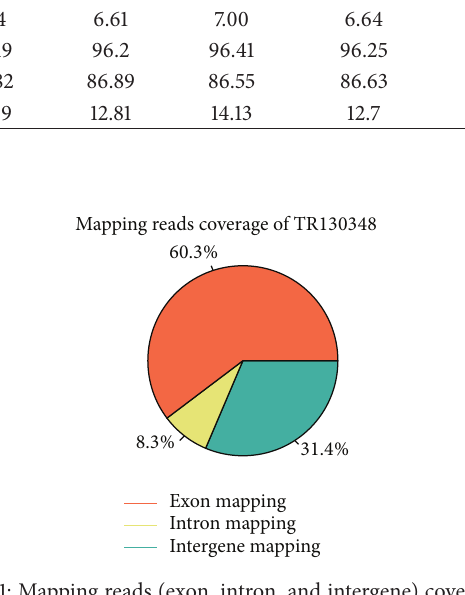
Figure 1: Mapping reads (exon, intron, and intergene) coverage of A (C0,